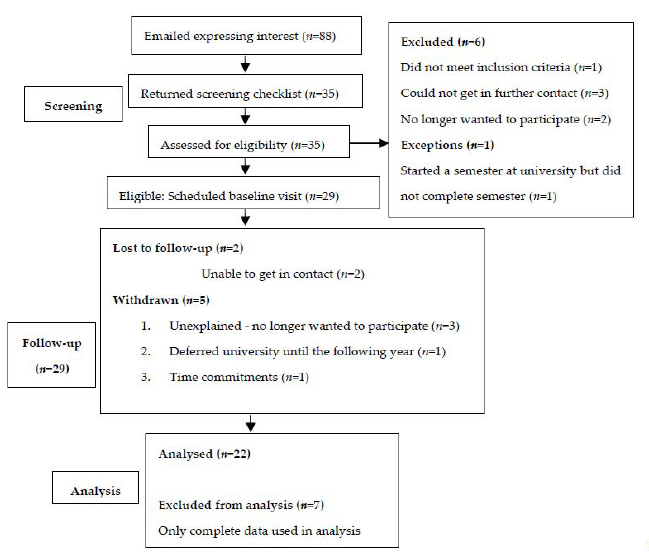
Figure 1. Consort chart outlining the UniStArt study process from participant screening and recruit- ment until analysis. A total of 29 participants enrolled in the study, while 22 participants were used for